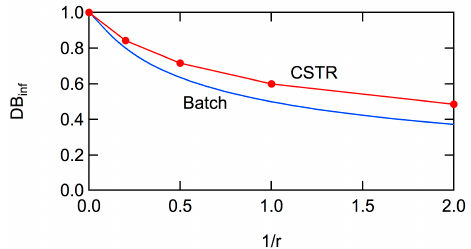
Figure 4. Relationship between DB inf and r for batch and CSTR. Data points were taken from the earlier publication [9].